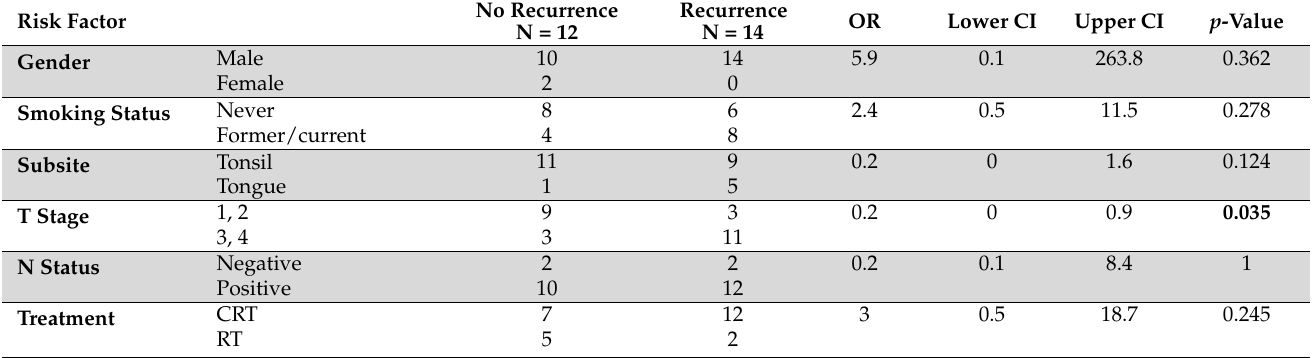
Table 2. Logistical Regression (recurrence vs. no recurrence for the HPV+ OPSCC patients).